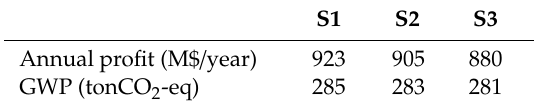
Table 8. Optimal objective values corresponding to the selected Pareto-optimal points in Figure 5.